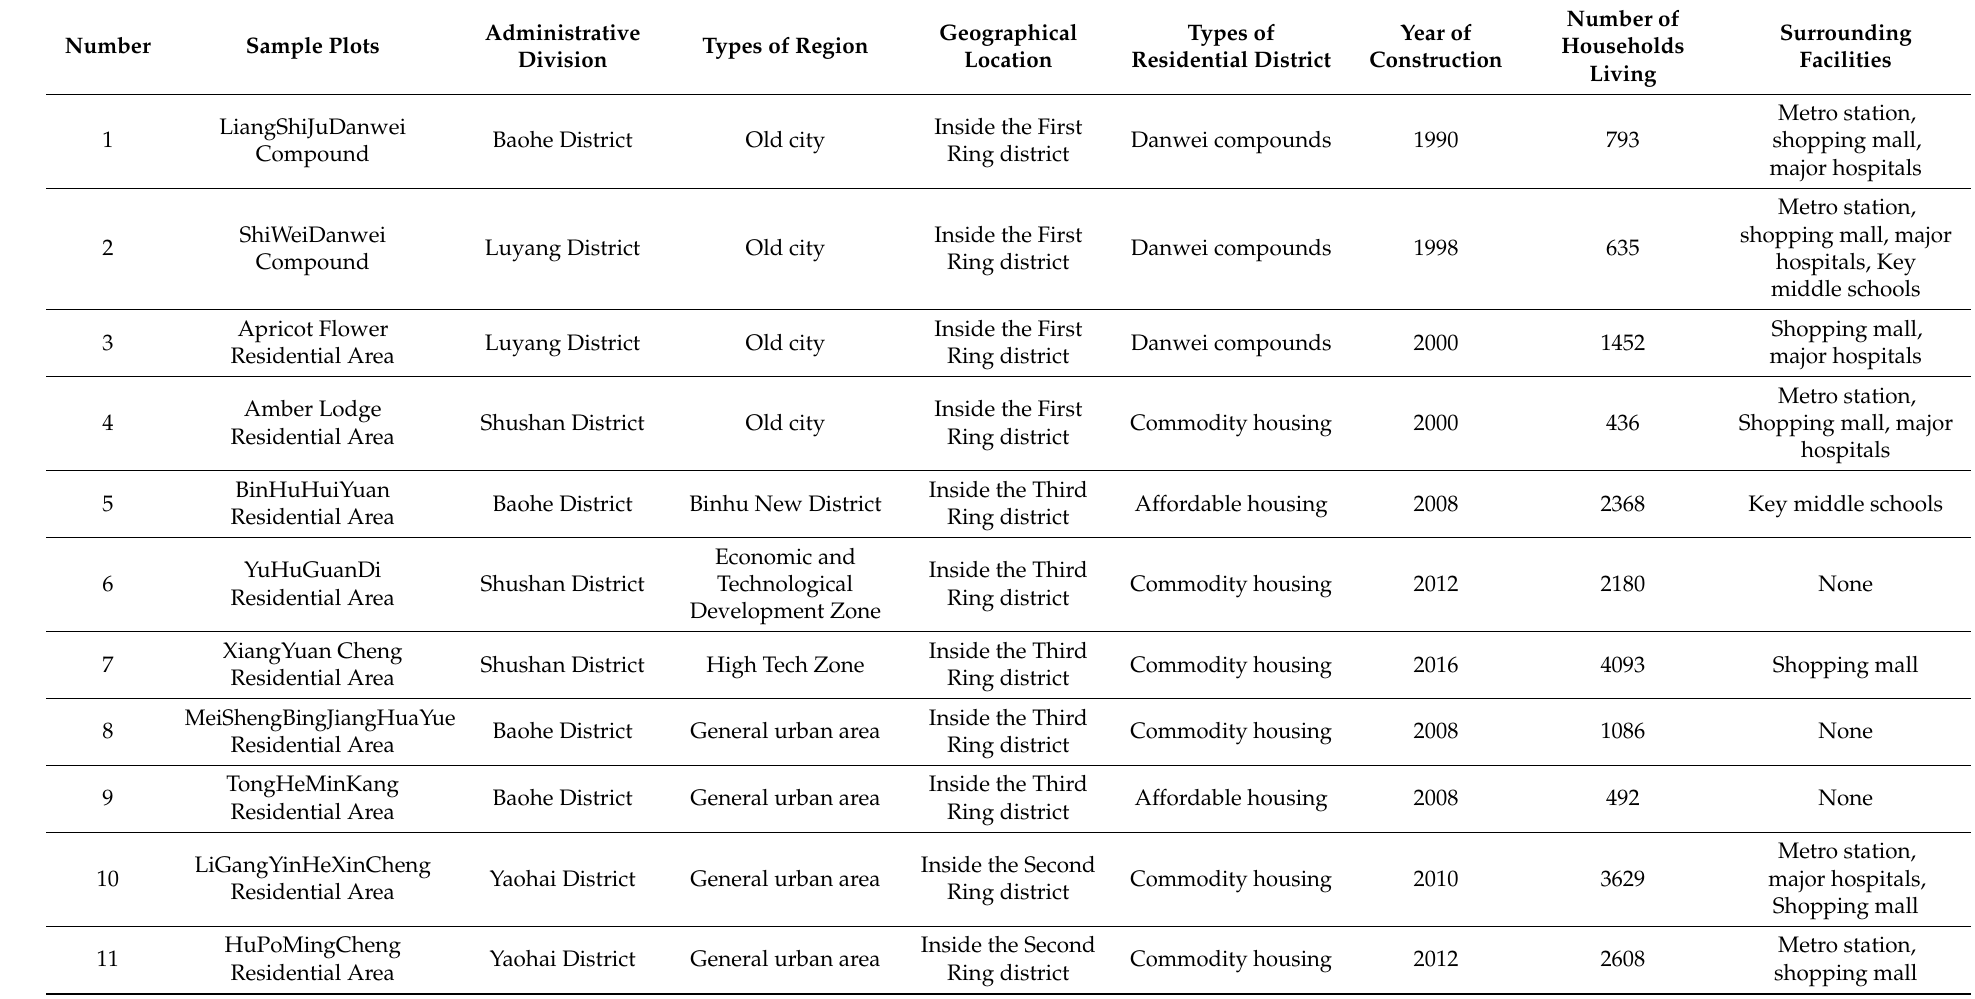
Table 1. Profile of residential